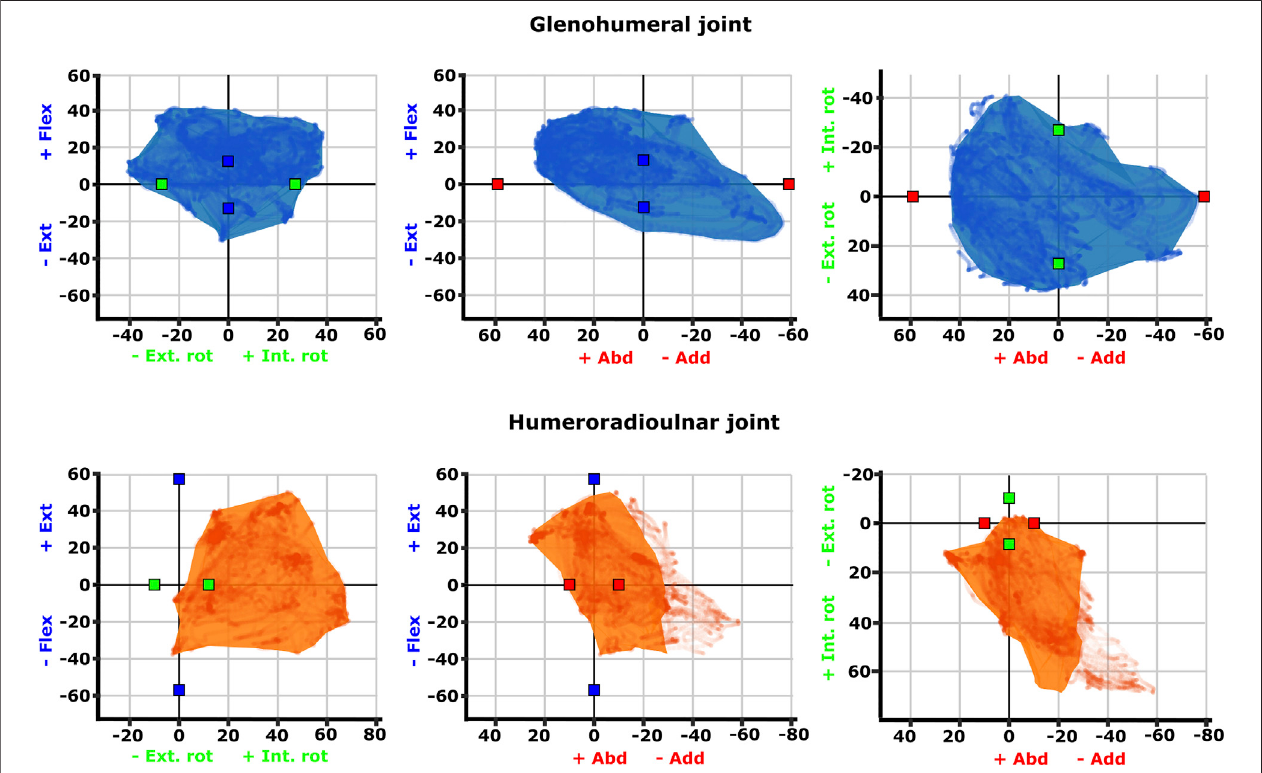
FIGURE4| Three-dimensional(3D)jointROMattheglenohumeraljoint(toprow,blue)andhumeroradioulnarjoint(bottomrow,orange).Notethataxisscalediffers between plots. The 3D envelopes encompass cosine-corrected experimental ROMs wrapped in a concave hull (alpha value 20), whilst the plotted points behind in the same colour show the uncorrected experimental ROMs. The initial model-predicted maximum ROMs for single DOF rotations from the zero (reference) position have been superimposed on the 3D plots as red (X), green (Y), and blue (Z) cubes (data from Regnault and Pierce (2018)). Individual specimen trial sets are illustrated in Supplementary Figure S4